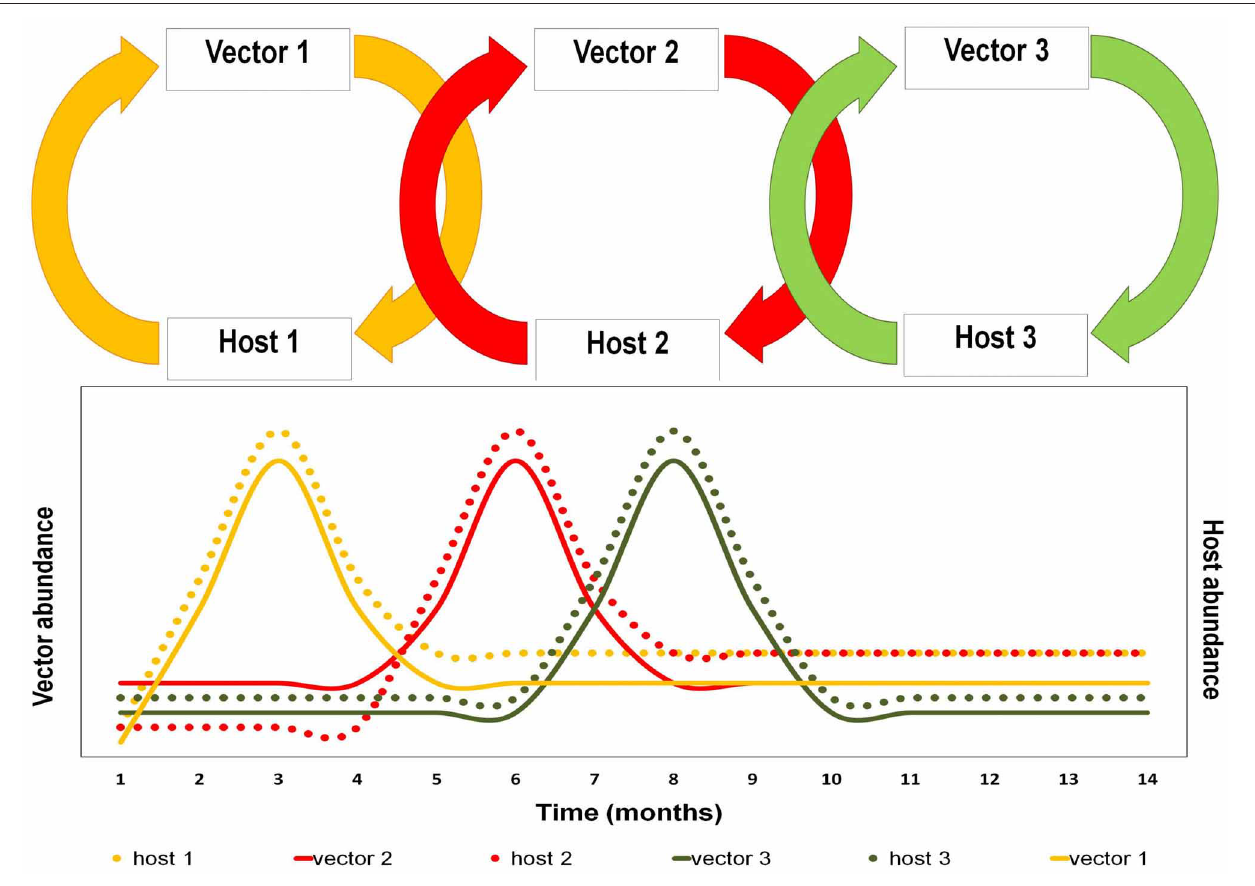
FIGURE 1 | Schematic representation of the sequencing changes as function in time in arbovirus transmission cycles. Foot figure: this figure represents the network for a hypothetical arbovirus in which transmission